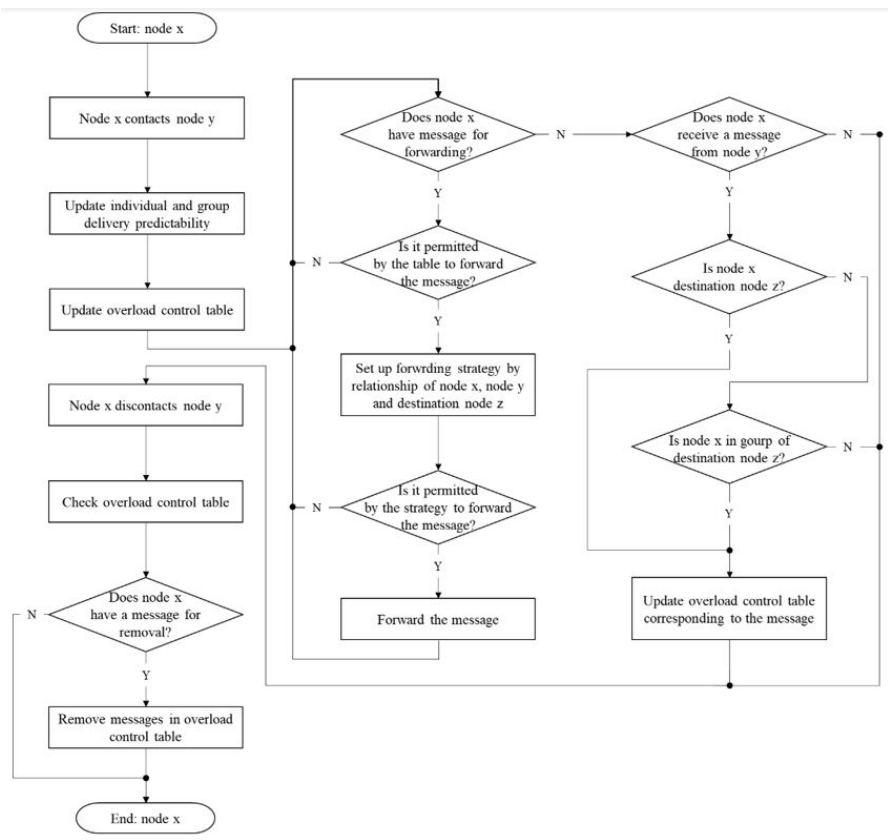
Figure 4. Flowchart of the proposed